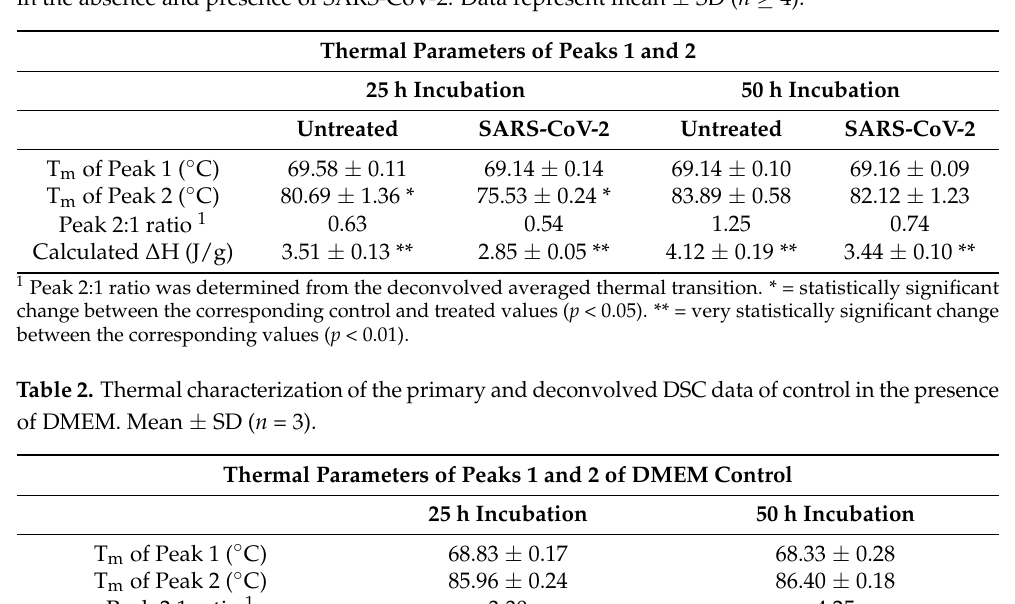
Figure 6. Anticoagulated human whole blood treated with DMEM (Dulbecco’s Modified Eagle Medium) as a control and incubated for 25 h and 50 h at 37 ◦ C. The measurements were performed three times independently ( n = 3) and the results are presented as mean ± SD. Table 1. Thermal characterization of the primary and deconvolved DSC data of human whole blood in the absence and presence of SARS-CoV-2. Data represent mean ± SD ( n ≥ 4).